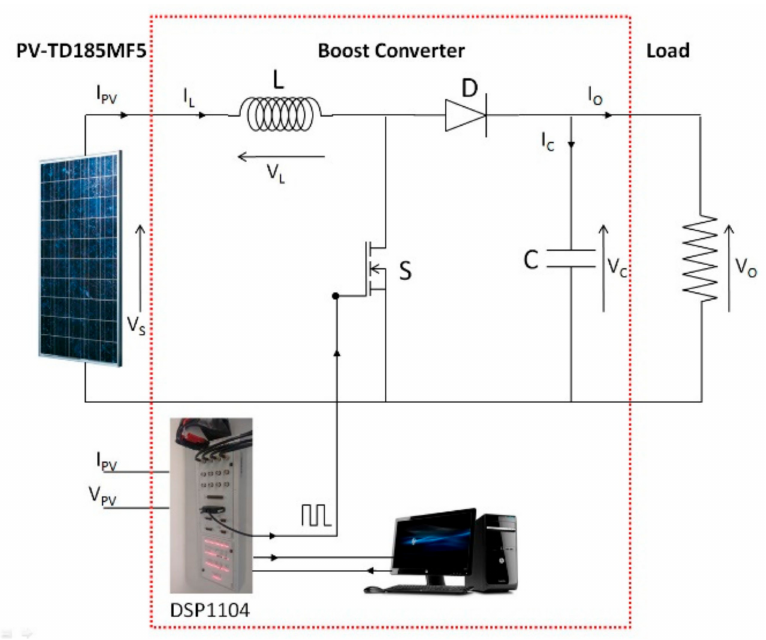
Figure 3. Boost Converter reproduced by permission from [19], Hindawi,